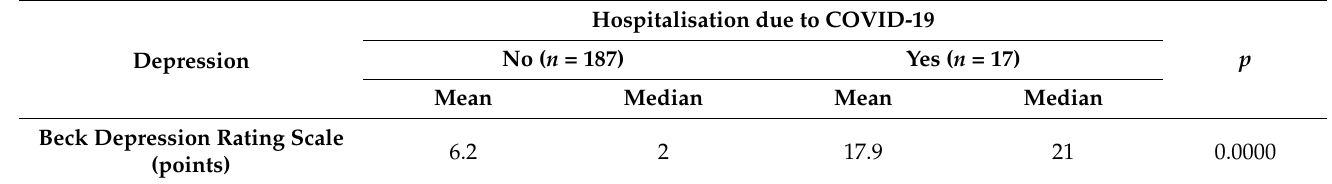
Table 8. Need for hospitalisation and depression.